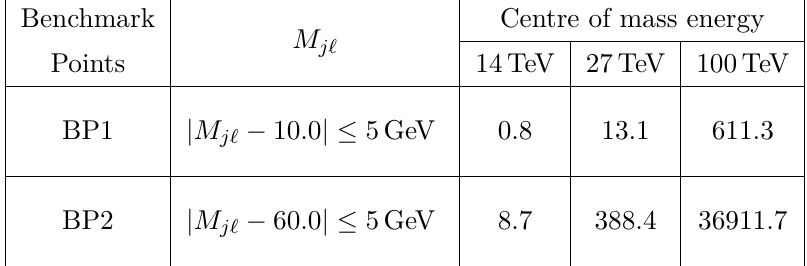
Table 4. The number of events in M j‘ distributions after the window cut around the mass peak for BP1, BP2 with the centre of mass energies of 14 TeV, 27 TeV, 100 TeV at the integrated luminosities of ( L = ) 3, 10 and 30 ab − 1 , respectively. int